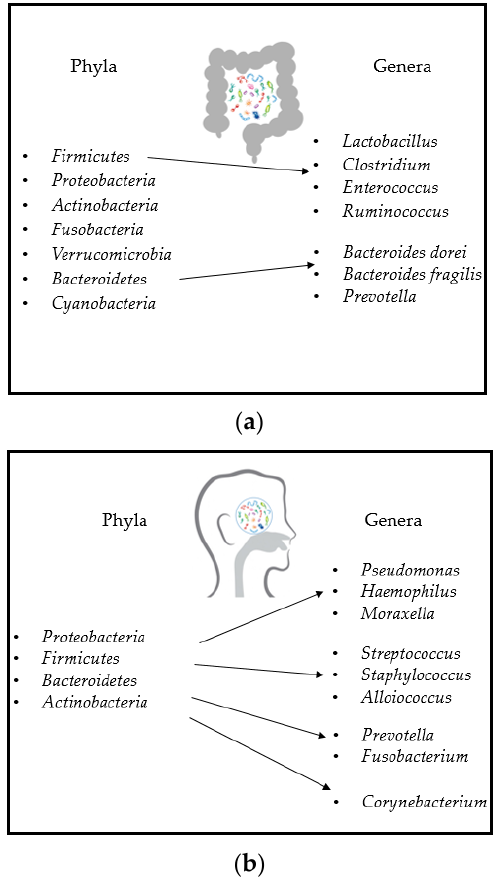
Figure 5. Microbiota composition: ( a ) main phyla and genera of a healthy gut microbiota [42]; ( b ) main phyla and genera of a healthy airway microbiota [44].